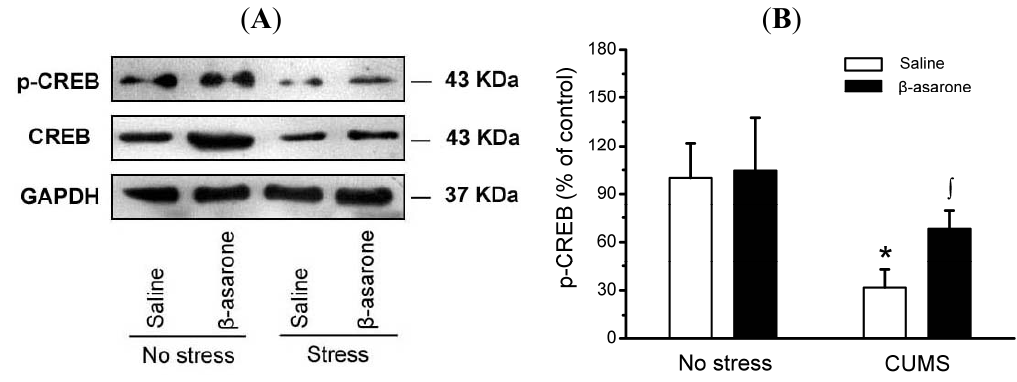
Figure 4. β -Asarone treatment increases ERK1/2 and CREB phosphorylation in hippocampus of CUMS-exposed rats. Rats were orally treated with β -asarone (25 mg/kg per day) or saline for 28 days while being exposed to CUMS or control